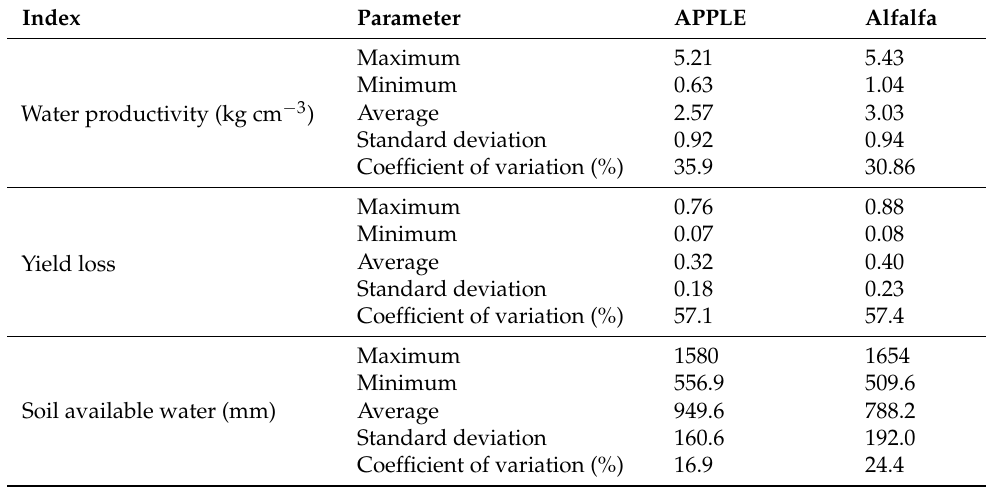
Table 3. Statistical values of crop yield, ET, and CWP from 2019 to 2038.